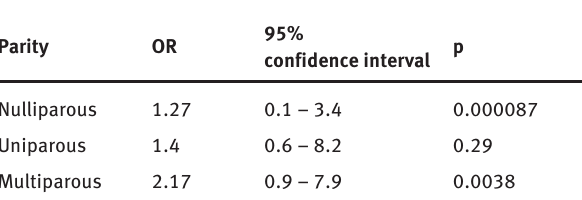
Table 10: Chance of getting ovarian cancer depending on other factors.